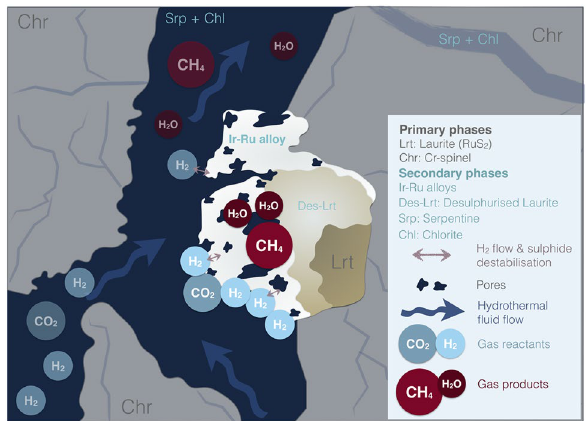
Figure 3. Suggested mineral catalyst. Model of the potential catalytic methanation sites of Ir–Ru–Os–Ni